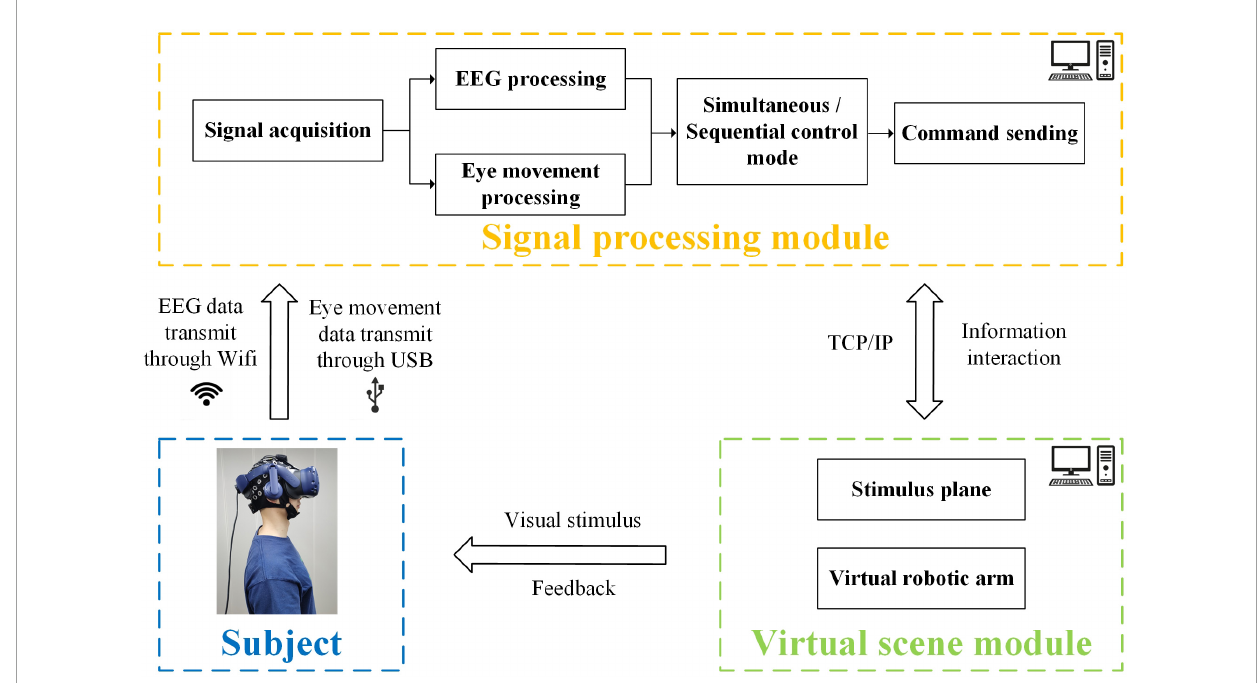
FIGURE1 Schematic diagram of virtual robotic arm control system combining EEG and eye-gaze.